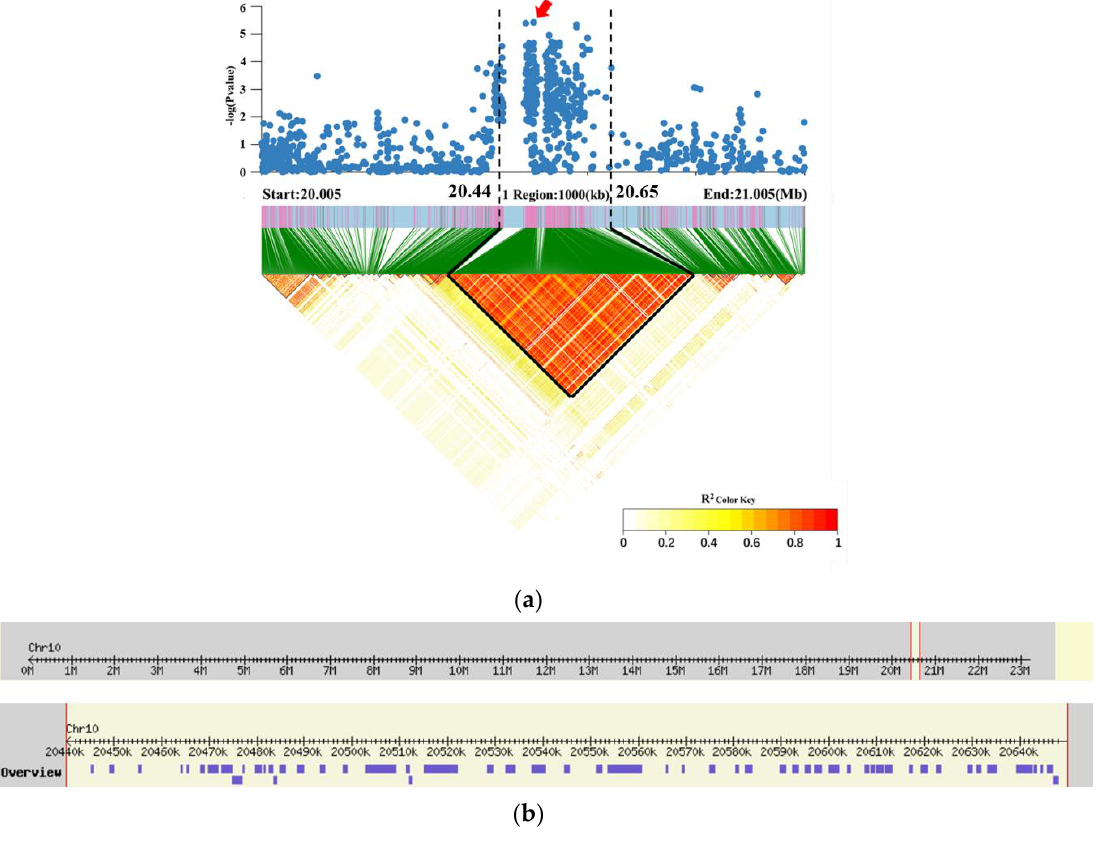
Figure 6. Candidate gene of qRG10 on chromosome 10. ( a ) Local Manhattan plot ( top ) and LD heatmap ( bottom ) surrounding the lead SNP. ( b ) Based on the Rice Annotation Project (RAP) [40], the 210 kb region contained 54 genes.